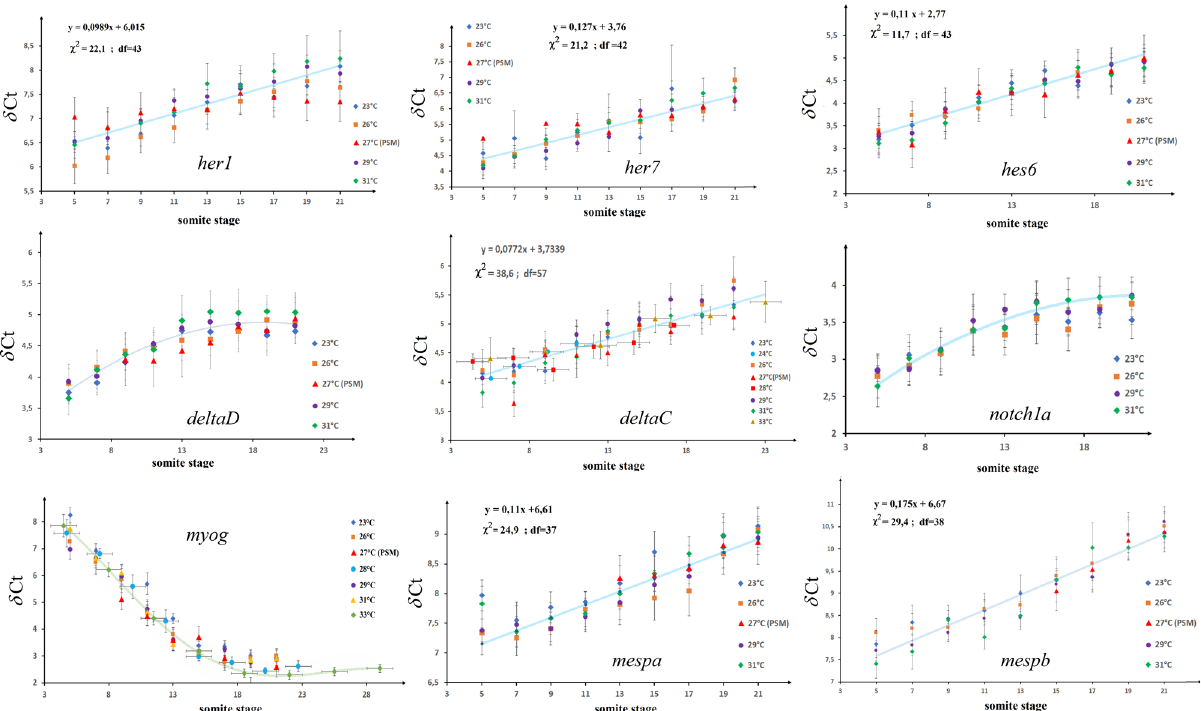
Fig. 8 Variation with temperature of various gene transcripts. The δ Ct of genes ( her1, her7, hes6, deltaC, deltaD, notch1a, myog, mespa , and mespb ) known to play a role in somitogenesis relative to reference genes ( rpl13a or β -actin ) are plotted as a function of somite stage. Notice that as a function of somite stage the data taken at different temperatures collapse on the same curve. For some genes for which δ Ct appears to vary linearly with somite stage (exponentially decreasing concentrations) we display the best fi t. For others the continuous curve is just a guide to the eye. The increasing concentration of myog (decreasing δ Ct values) is consistent with its role as a differentiation factor during myogenesis which follows somite